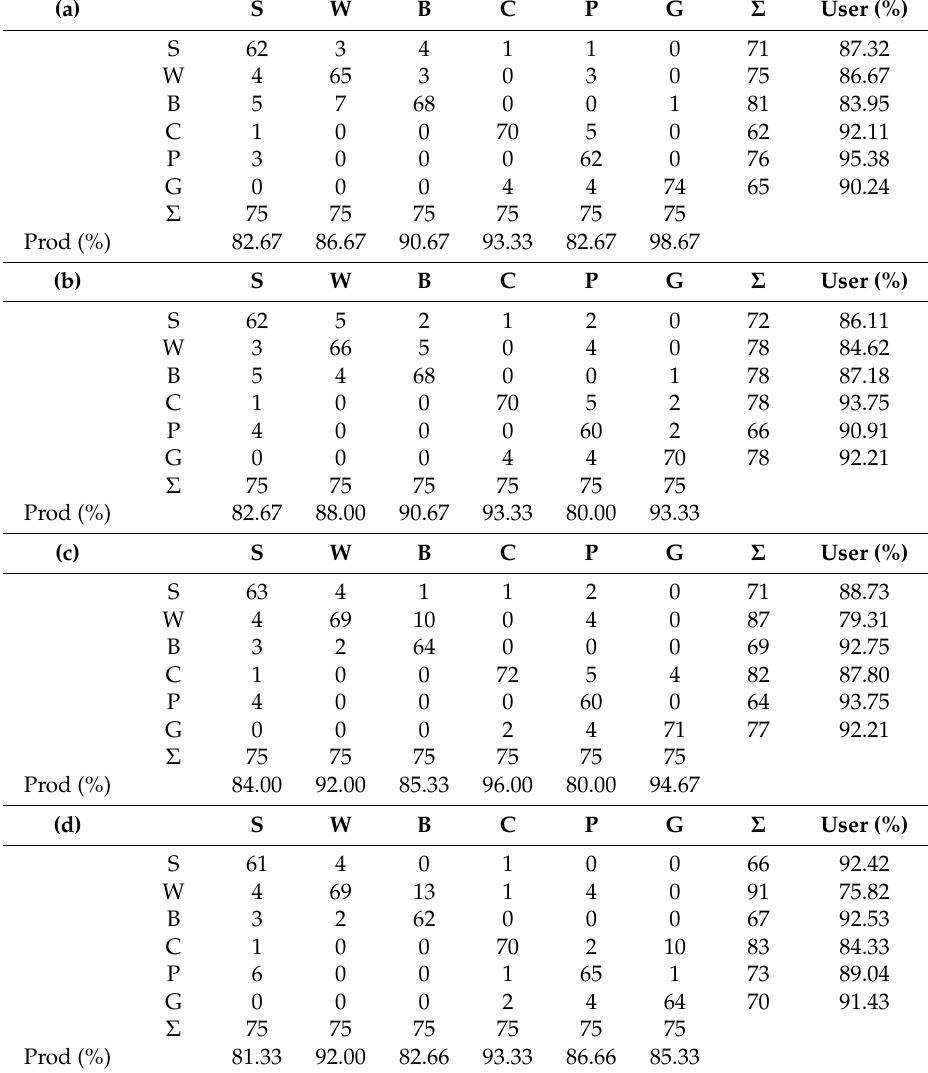
Table 2. Confusion matrices for classifications using error-free training data: ( a ) SVM; ( b ) RVM; ( c ) SMLR; and ( d ) discriminant analysis. Columns show reference data and rows the classification labels. Also shown are user’s (User) and producer’s (Prod) accuracy. Classes are defined in Section 4.1.